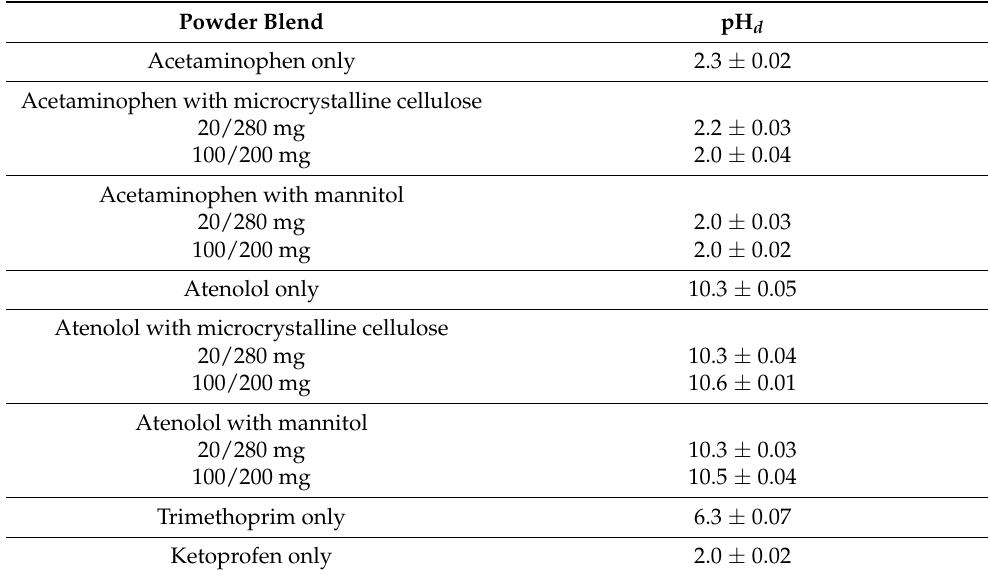
Table 2. Diffusion layer pH (pH d ) of drug or drug/diluent mixtures at different ratios (data presented as mean ±